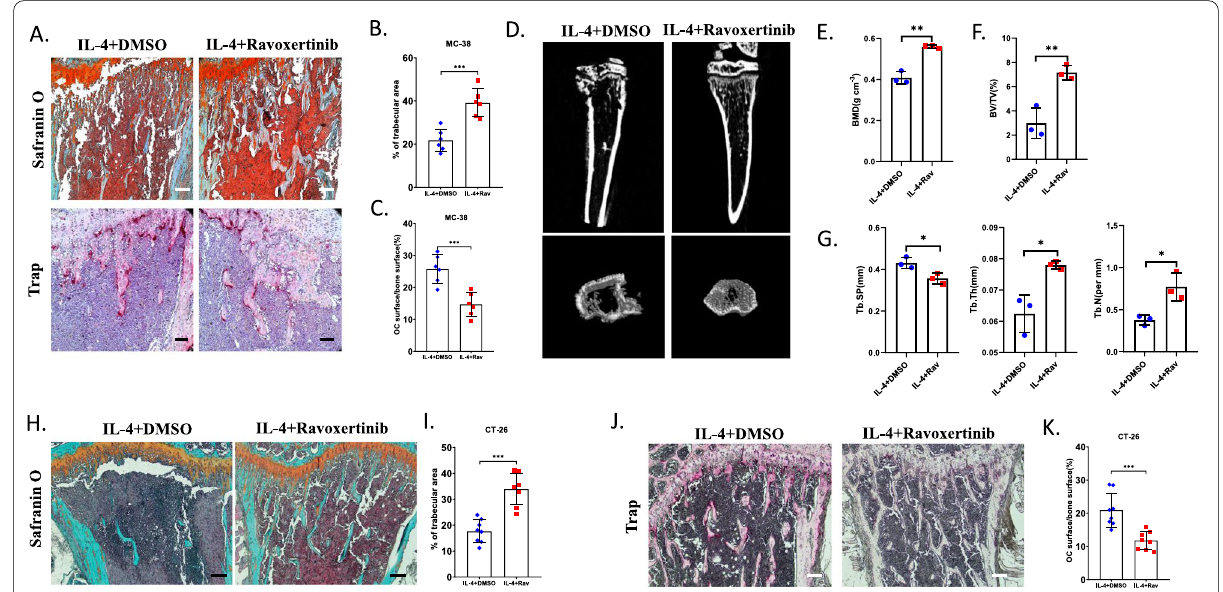
Fig. 5 Blockage of ERK pathway significantly attenuating osteolysis in metastatic bone of CRC. A – C Histochemistry analysis and TRAP staining showed the bone resorption in tibias at 21 days post injection of MC‑38 cells after administration of Ravoxertinib in the presence of IL‑4 (Scale bar 100 μm) ( A ) and the quantification of trabecular area ( B ) and the quantification of area of OCs ( C ). (n 6) D – E μCT analysis showed the bone = = resorption in tibias at 21 days post injection of MC‑38 cells after administration of Ravoxertinib in the presence of IL‑4 ( D ) and compared the bone mineral density (BMD) of tibias at 21 days post injection of MC‑38 cells after administration of Ravoxertinib in the presence of IL‑4 ( E ). (n 3) F , G = Quantification of trabecular bone volume fraction (BV/TV) ( F ), trabecular thickness (Tb.Th), trabecular number (Tb. N) and trabecular separation (Tb. Sp) ( G ) of tibias at 21 days post injection of MC‑38 cells after administration of Ravoxertinib in the presence of IL‑4. (n 3) ( H – I ) Histochemistry = analysis showed the bone resorption in tibias at 21 DPI after injection of CT‑26 cells in IL‑4 treated mice with/without treatment of Ravoxertinib (Scale bar 100 μm) ( H ) and quantification of trabecular area ( I ). (n 8) ( J – K ) TRAP staining showed the area of OCs at 21 days post injection of = = CT‑26 cells (Scale bar 100 μm) ( J ) and the quantification of OC area in bone surface ( K ). (n 8) *p < 0.05, **p < = =